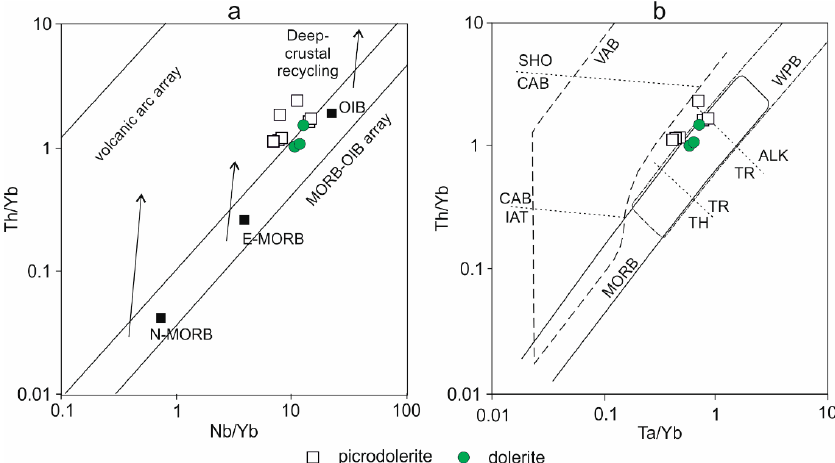
Figure 10. Tectonic discrimination diagrams for the mafic studied rocks. ( a ) Th/Yb vs. Nb/Yb from [47]; ( b ) Th/Yb vs. Ta/Yb from [48]. Abbreviations are the types of mafic volcanic rocks: MORB—middle ocean ridge basalts; N-MORB—normal of middle ocean ridge basalts; E-MORB—enriched of middle ocean ridge basalts; OIB—ocean islands basalts; WPB—within plates basalts; ALK—alkalic; TH—oceanic tholeiitic; VAB—volcanic arcs basalts; IAT—island arc tholeiitic; CAB—calk-alkaline basalts; SHO—shoshonitic; TR—transitions between ALK and TH.